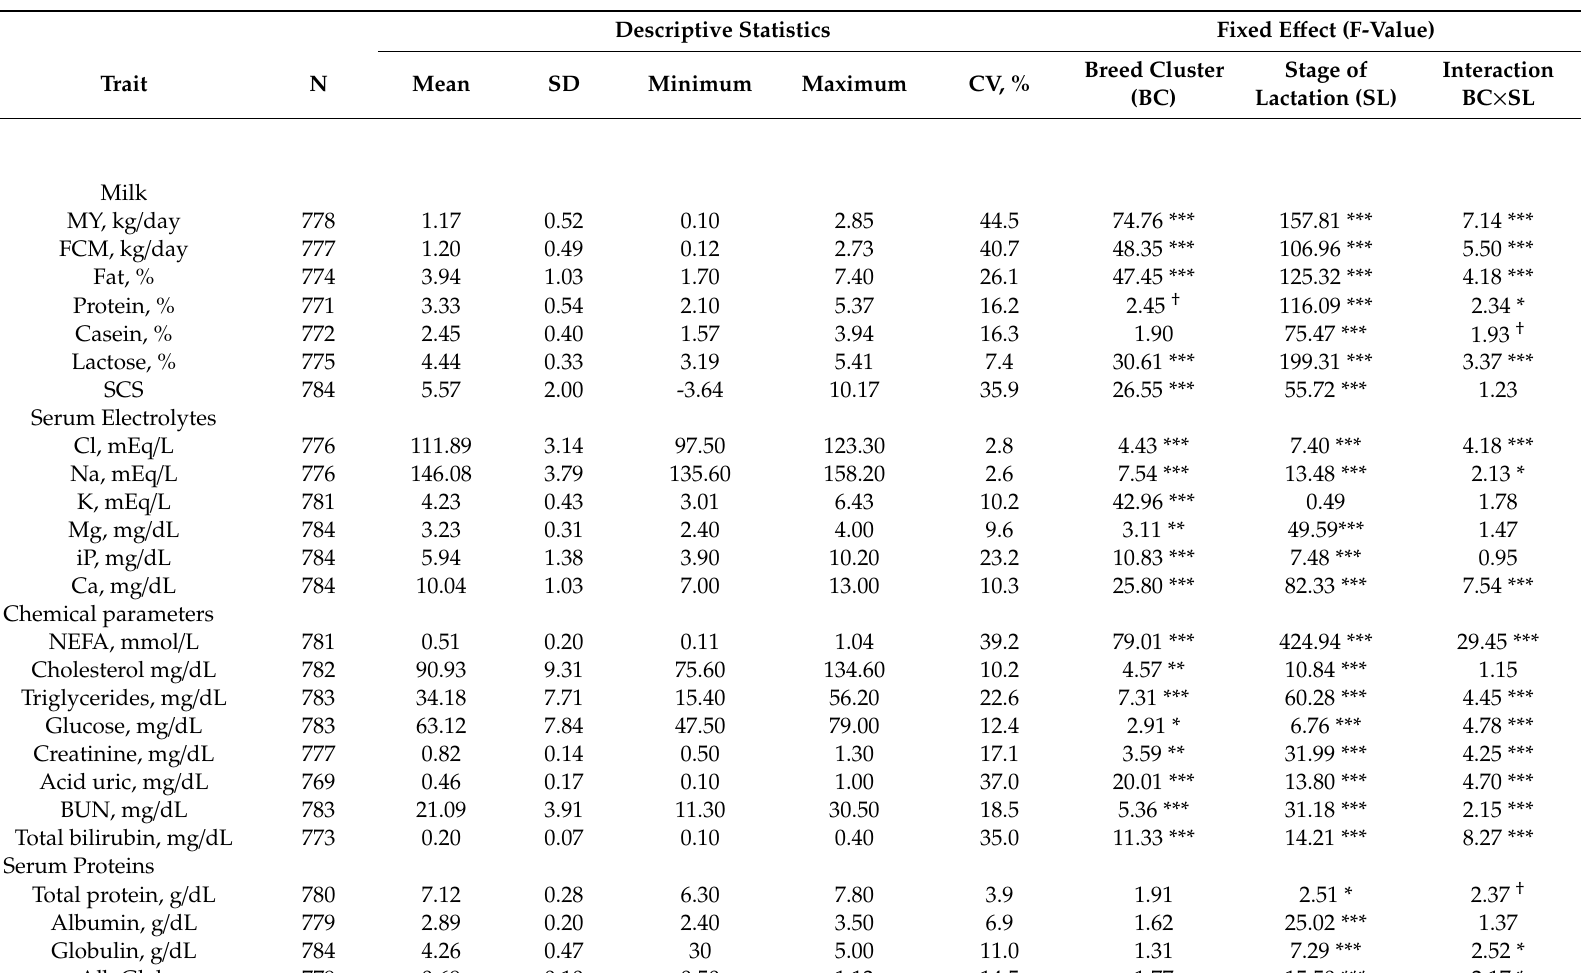
Table 1. Overall descriptive statistics of milk yield, somatic cell score, milk chemical composition, and metabolic, mineral, and oxidative plasmatic profile of goats in a complete lactation. It also reported the F-values and significance of the fixed e ff ects included in the statistical